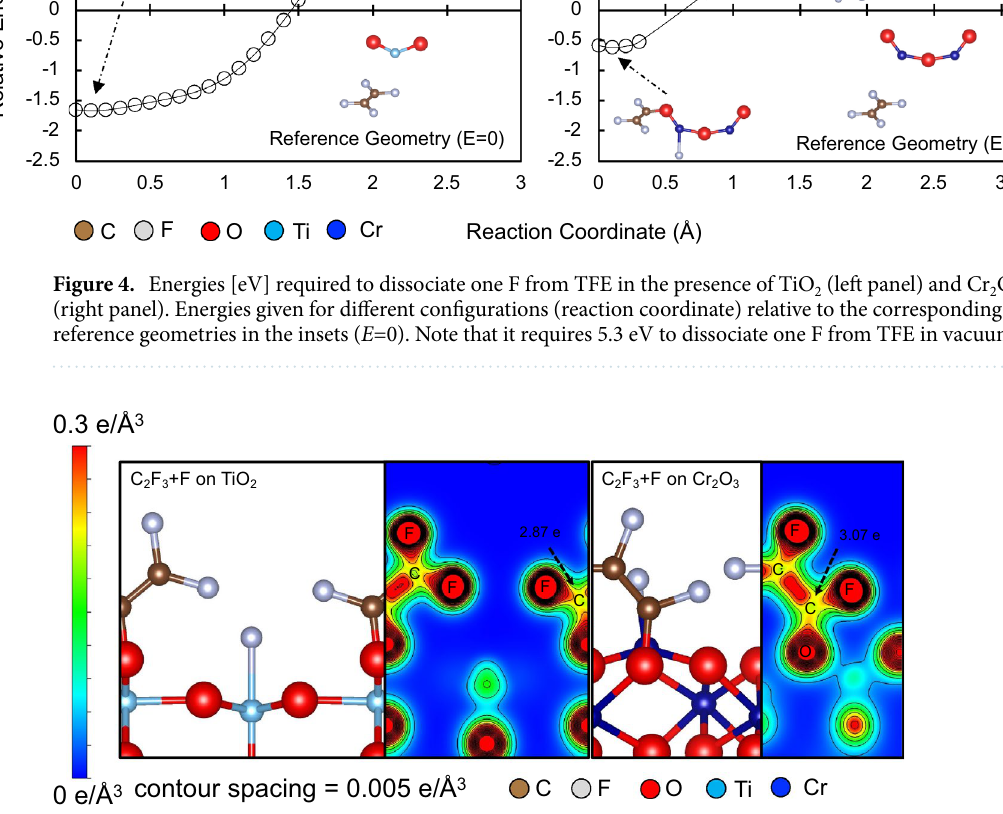
Figure 5. Charge density distributions for TFE adsorbed (dissociated) as C 2 F 3 and F on TiO 2 (110) (left panel) and on Cr 2 O 3 (0001) (right panel). A higher accumulation of charge about the C 2 F 3 C=C observed on